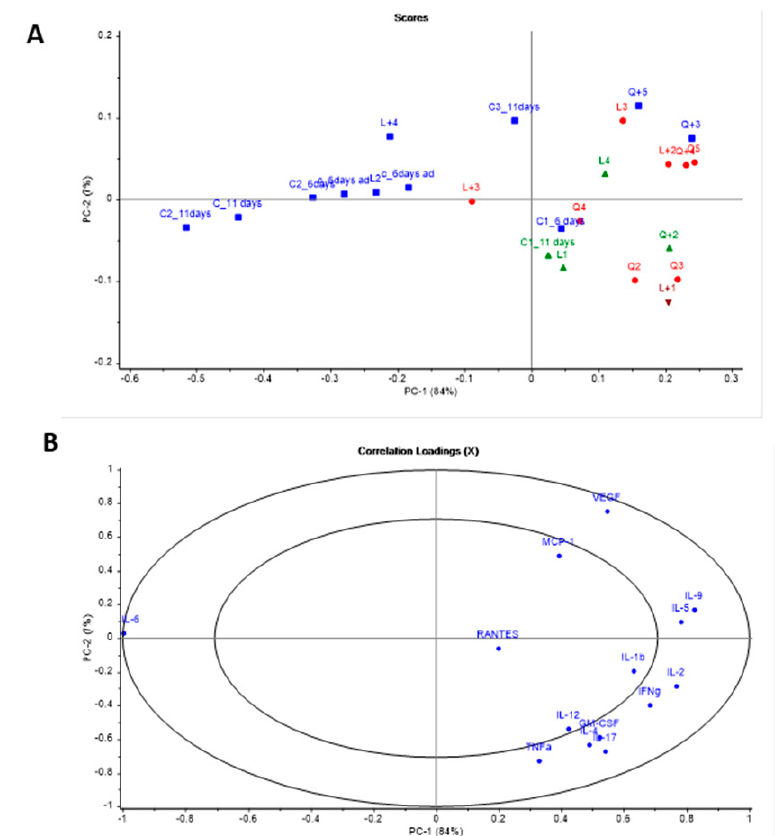
Figure 5. Principal component analysis of the cytokine profile at day six and 11 for control group and at day 11 post-infection for all treatment groups. ( A ) Score plot. ( B ) Correlation loading plot. Key: C represents animals from the untreated control group; L- animals treated with LAMB and Q- animals treated with AMB-MET.